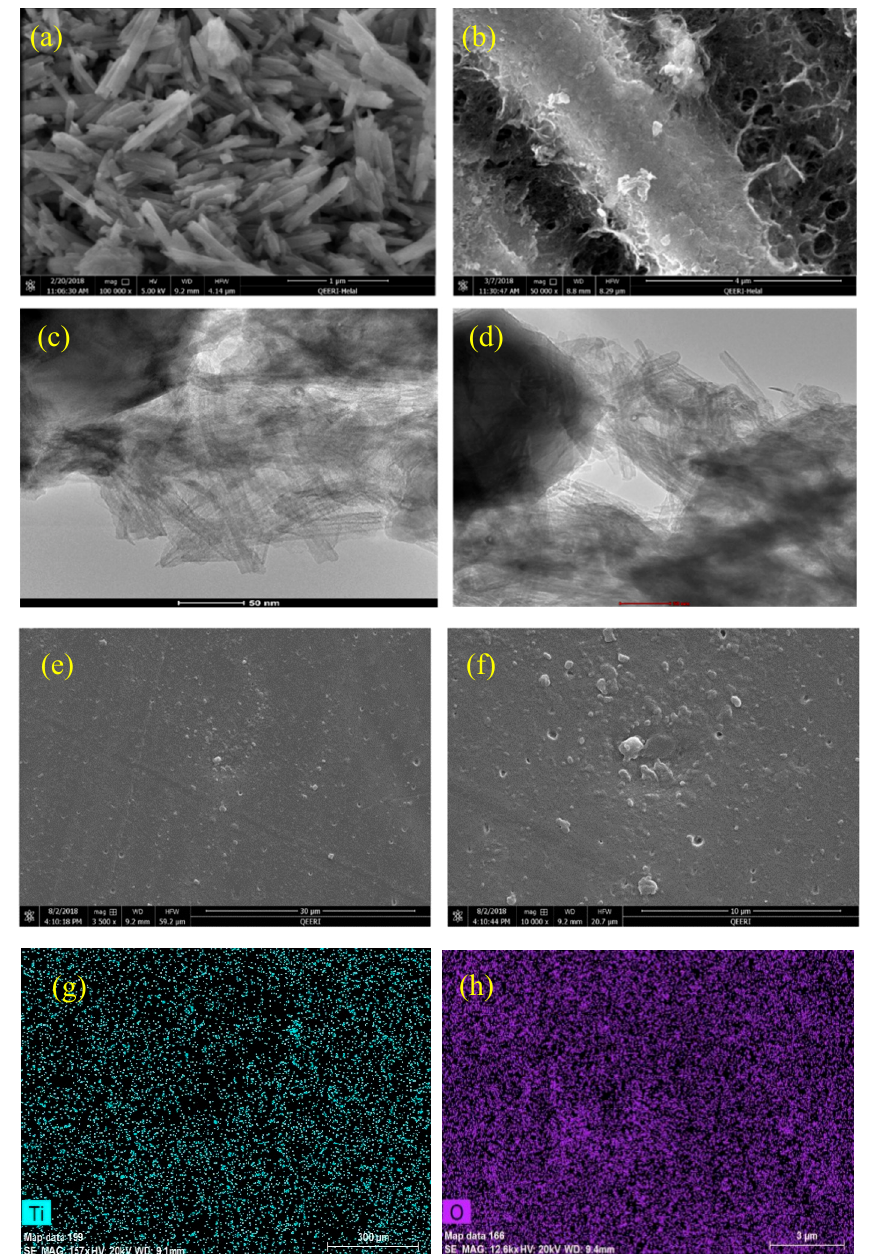
Figure 2. FE-SEM images: ( a ) As-synthesized TNTs, ( b ) TNTs loaded with DOC; HRTEM Images: ( c ) As-synthesized TNTs ( d ) TNTs loaded with DOC, ( e,f ) epoxy coating with 5 wt.% loaded nanocontainers ( g,h ) EDX elemental mapping showing the presence of Ti and O.